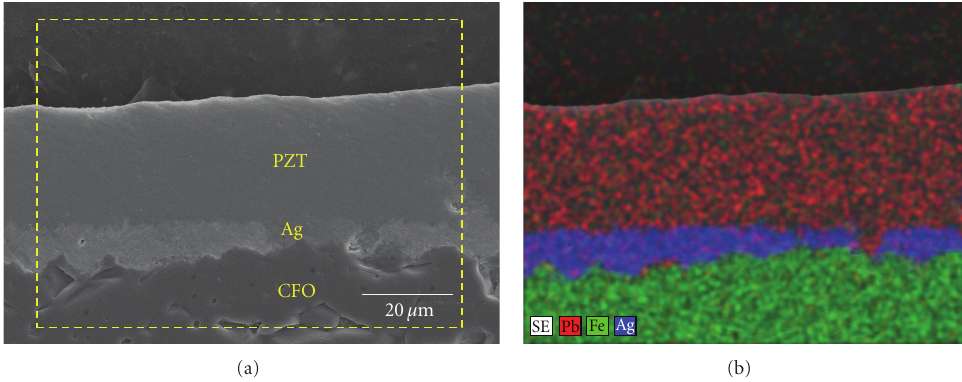
Figure 11: (a) cross-sectional SEM micrographs and (b) EDX mapping of 2-2 ME composite thick films by